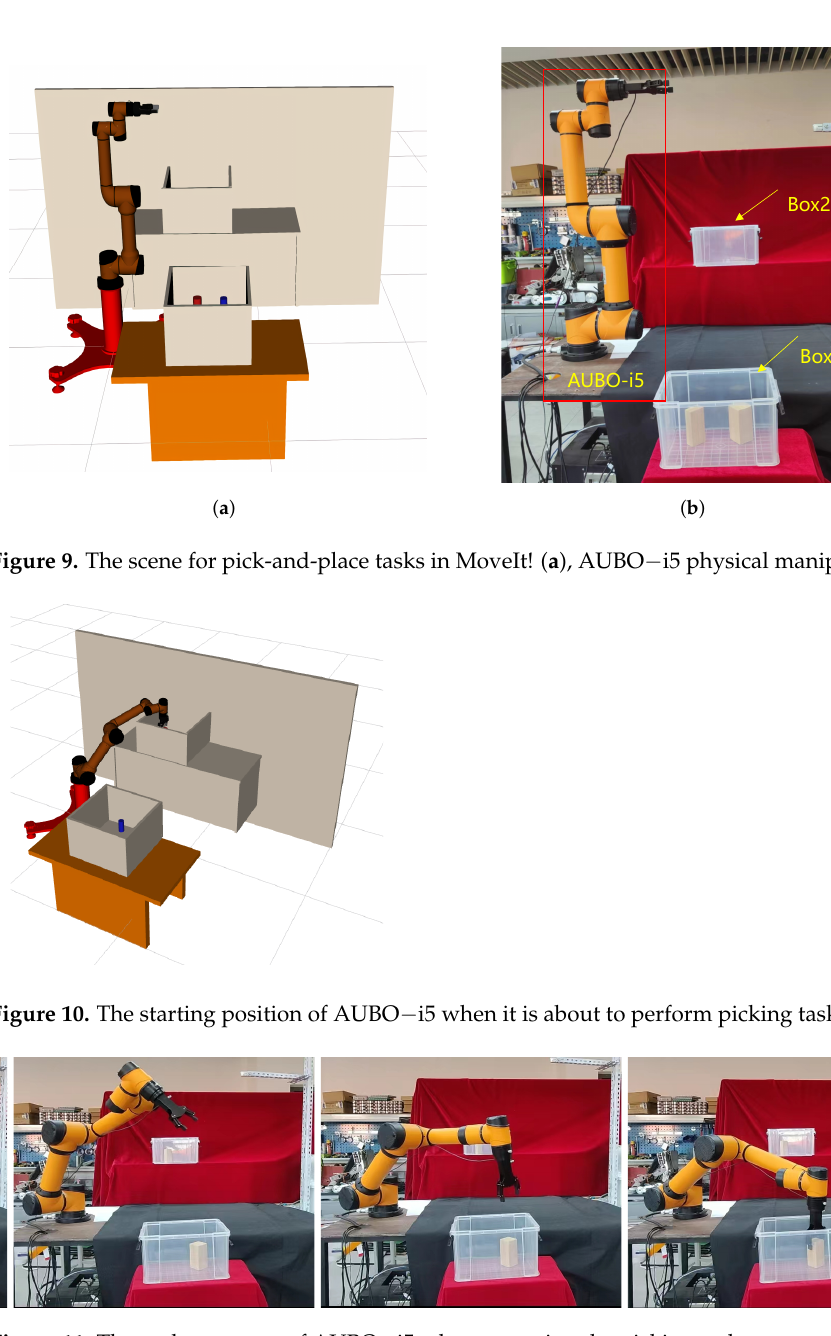
Figure 11. The path sequence of AUBO − i5 when executing the picking